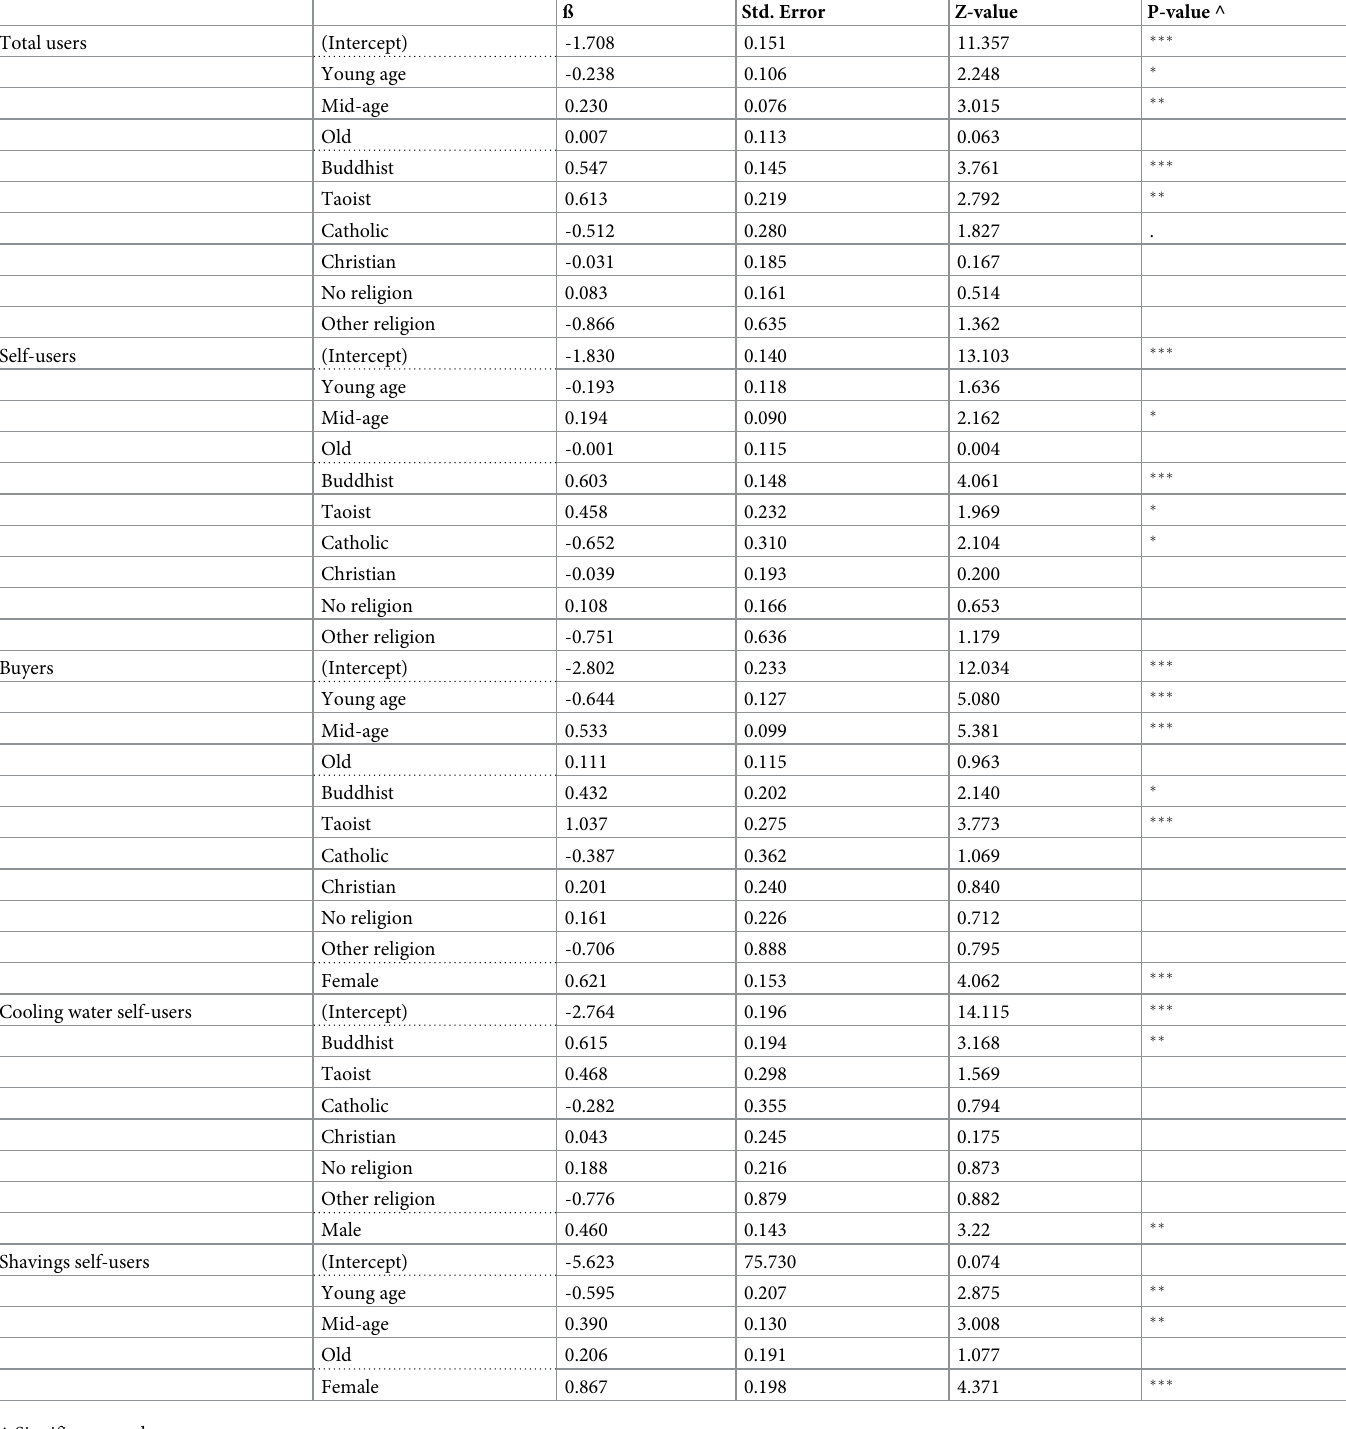
Table 3. The full averaged-model coefficients of variables with significant p-values, shown for each consumer sub-group. ß Std.